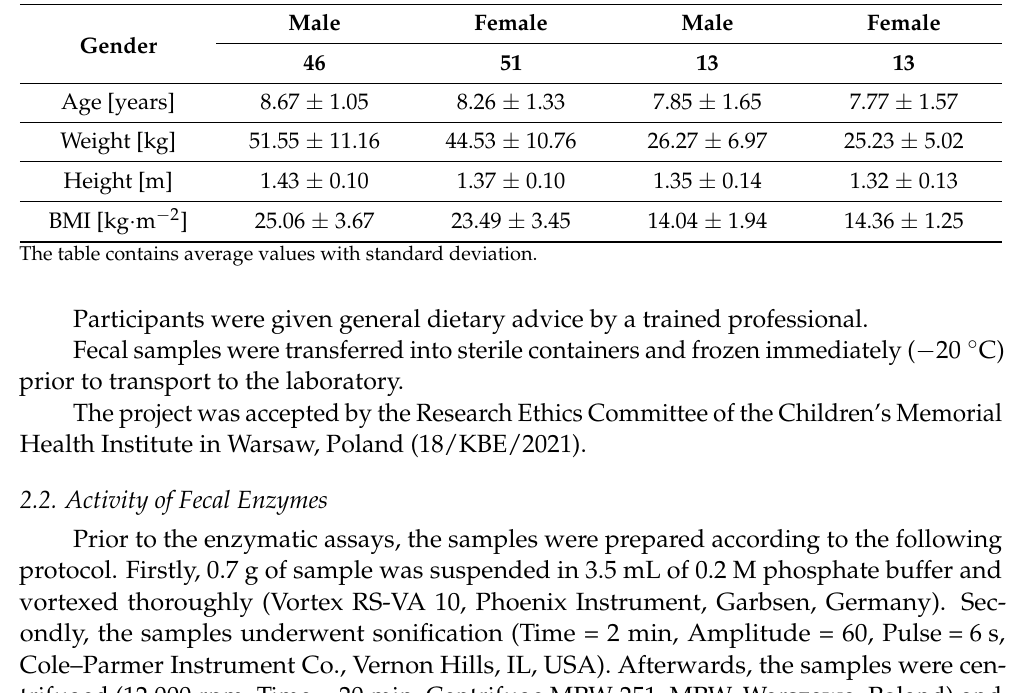
Table 1. Characterization of the participants of the study. Participants of the Study Overweight and Obese